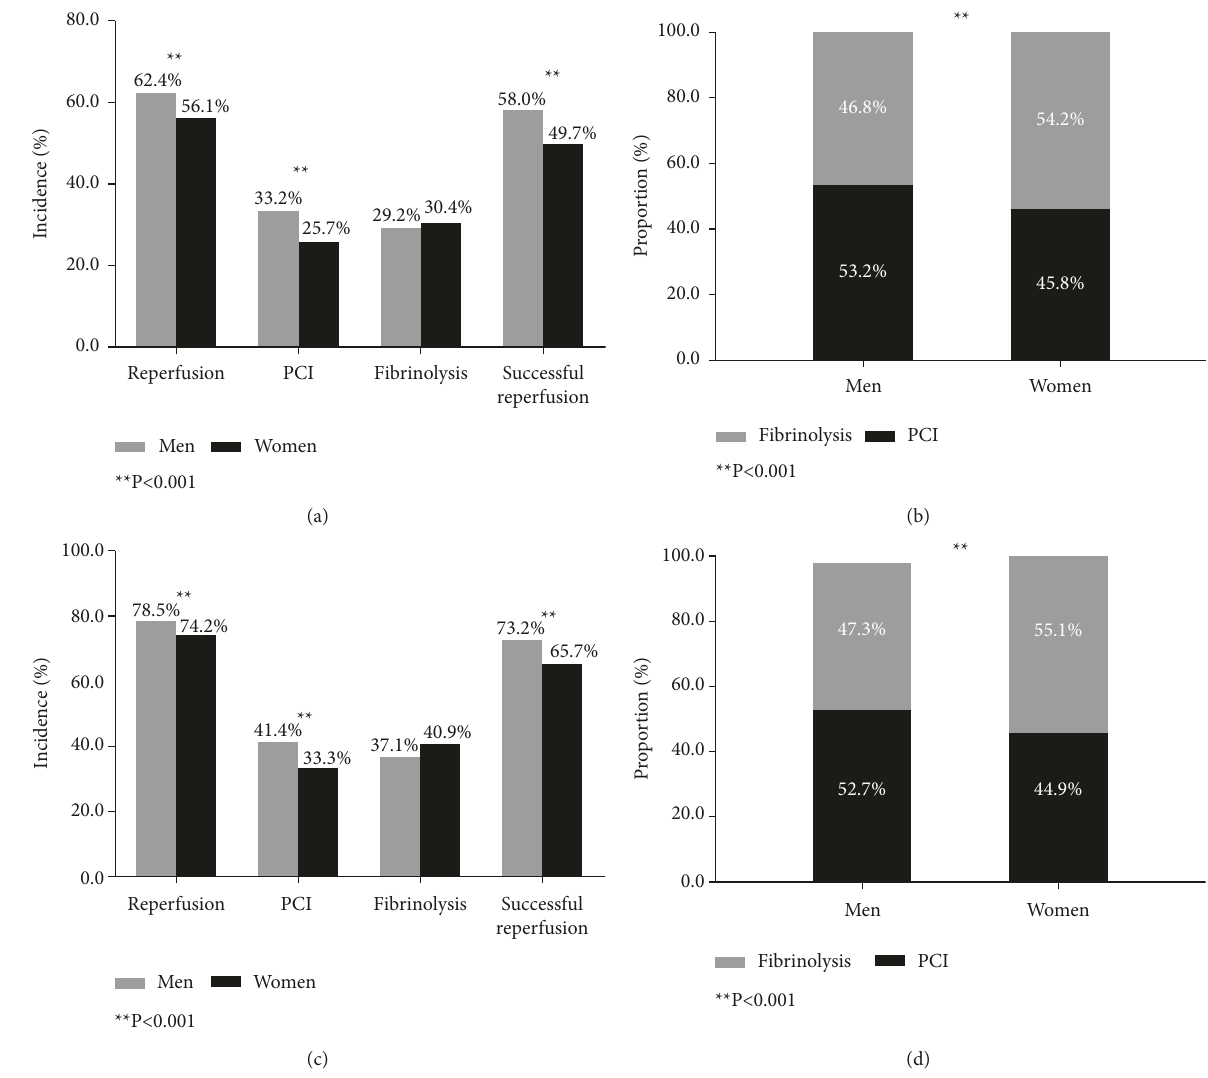
Figure 1: Use of reperfusion therapy based on sex in STEMI patients. In-hospital reperfusion strategy of all STEMI patients (240 patients with reperfusion contraindication were excluded) (a, b) and reperfusion eligible patients (admitted within 12 hours after symptom onset) (c, d). With regard to therapeutic strategies, 62.4% of male and 56.1% of female patients received reperfusion therapy ( P < 0 . 001), PCI was performed in 25.7% of females versus 33.2% in males ( P < 0 . 001), 49.7% of females versus 58.0% of males were successful reperfusion ( P < 0 . 001) (a), and fibrinolysis was the major reperfusion therapy in female (b). Of the reperfusion eligible patients, 78.5% of male and 74.2% of female patients received reperfusion therapy ( P < 0 . 001), PCI was performed in 33.3% of females versus 41.4% in males ( P < 0 . 001), 65.7% of females versus 73.2% of male were successful reperfusion ( P < 0 . 001) (c), and fibrinolysis was still the major strategy of reperfusion in female (d). STEMI, ST-elevation myocardial infarction; PCI, percutaneous coronary